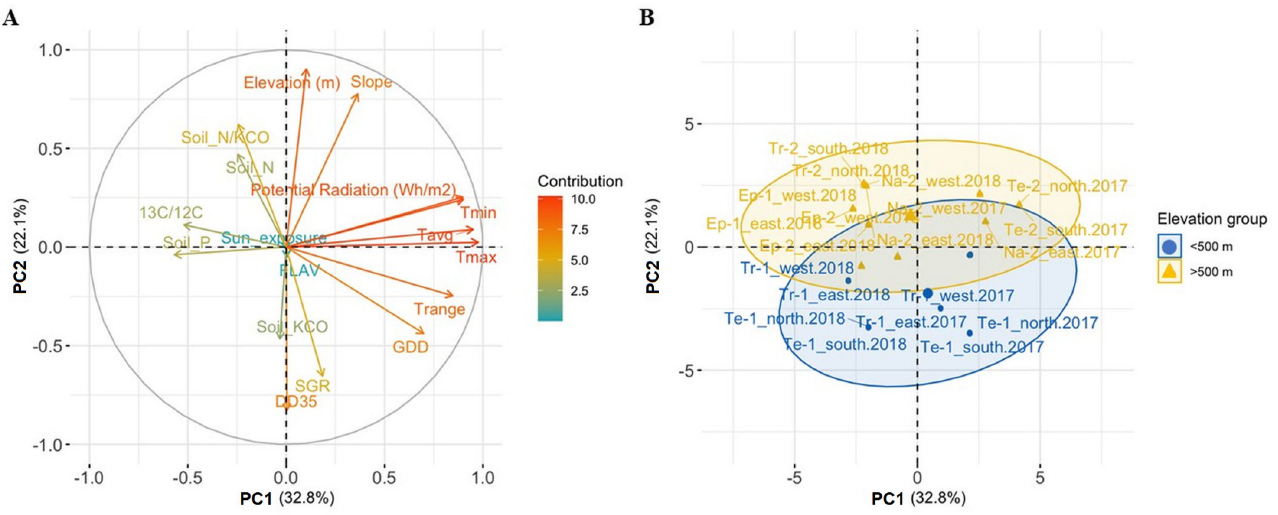
Fig 4. PCA of PC1-PC2 of agro-climatic variables and grape bunch flavonol content, FLAV. Loading plot (A) and scores plot (B) on PC1 and PC2 (observation are grouped according to the elevation range: Green ellipse < 500 m a.s.l., blue ellipse > 500 m a.s.l.,) showing the contribution of variables and individuals, respectively, to each PC and C) shows the biplot that overlays loadings plot and scores plot on PC1 and PC2. Individual points (coloured by FLAV content averaged on three replicates) represent the observations; variables (arrows) are coloured according to different categories [elevation, temperature parameters and indices, e . g ., GDD and DD35, stable carbon isotopic fraction, slope, and mineral soil content (N, P, and KCO)].